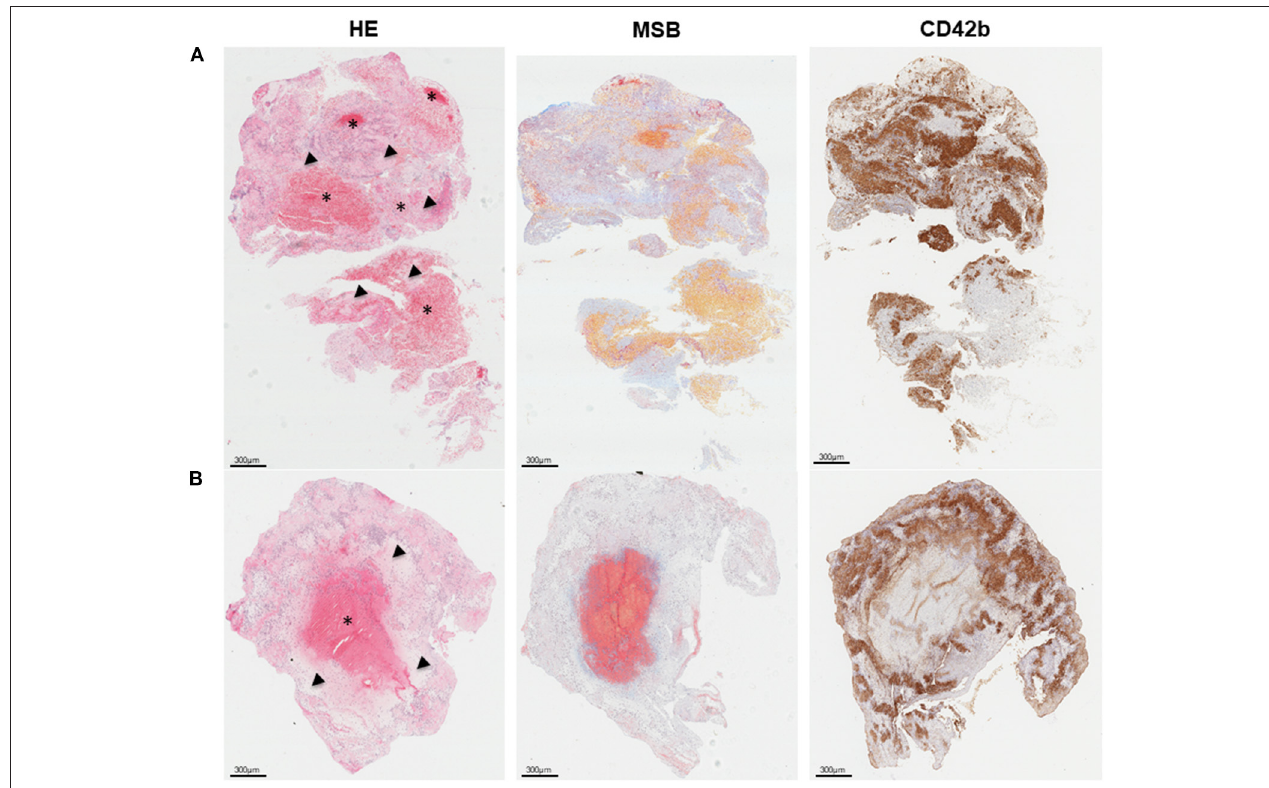
FIGURE 1 | Overall thrombus composition and organization. (A) Red blood cell (RCB)-rich (asterisk) and platelet-rich areas (arrow head) are patchly distributed within thrombi. (B) Some thrombi present an RBC-rich core surrounded by platelet-rich material. From left to right, representative histological images of consecutive thrombi sections stained with hematoxylin and eosin (H&E), allowing identification of fibrin/platelet aggregates (pink), RBC (red), and nucleated cells (dark blue); Martius Scarlet Blue (MSB) showing the presence of fibrin (dark pink/red), RBC (yellow), and collagen (blue); and CD42b (brown) for platelets. Scale = 300 µ